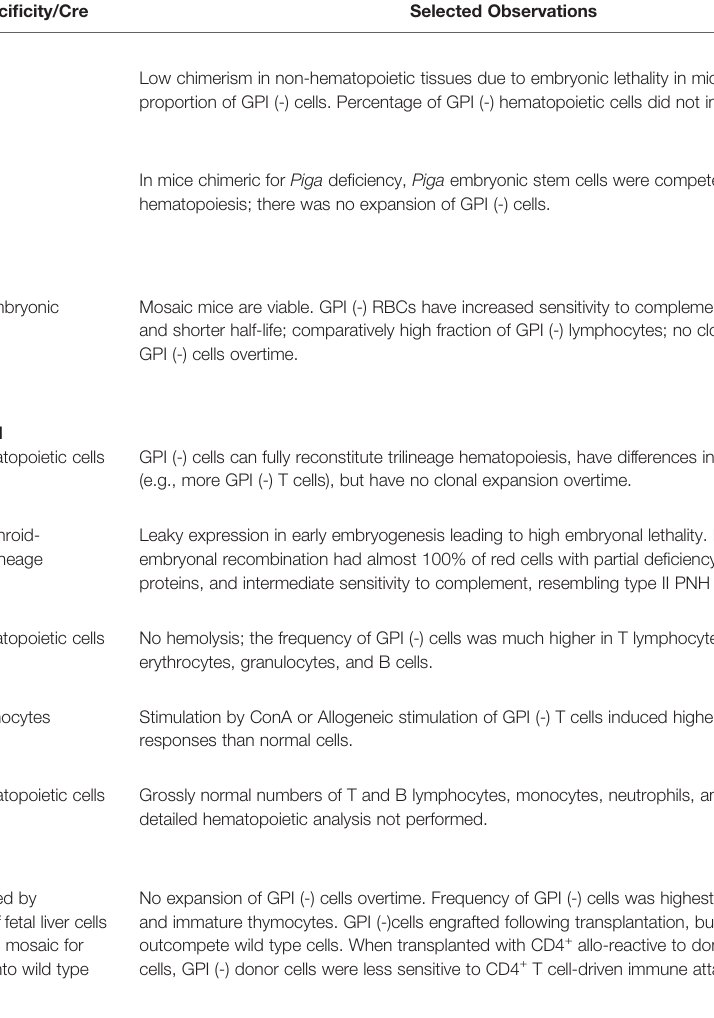
TABLE 1 | Summary of animal models of paroxysmal nocturnal hemoglobinuria.